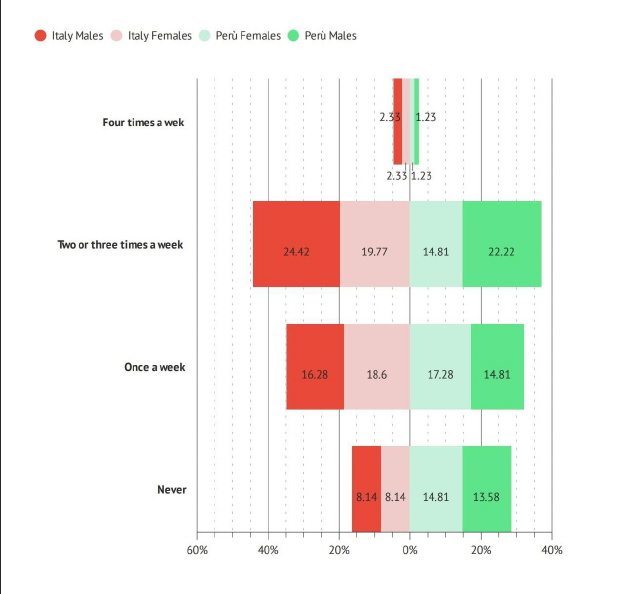
FIGURE5 Percentage of dentistry professionals engaging in physical activity (times a